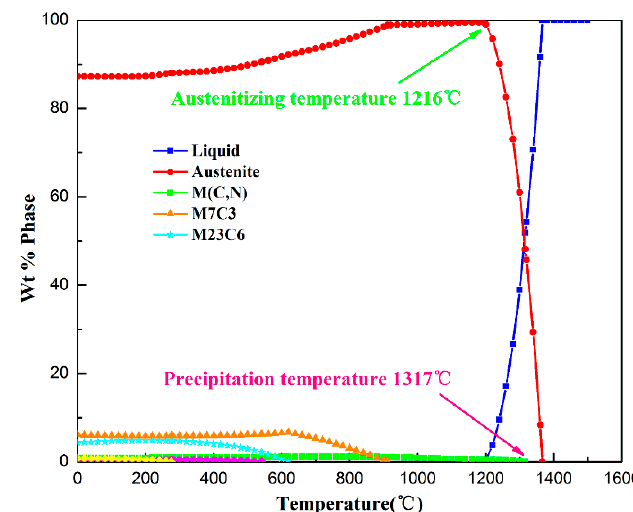
Figure 3. Phase equilibrium diagram of experimental steel.